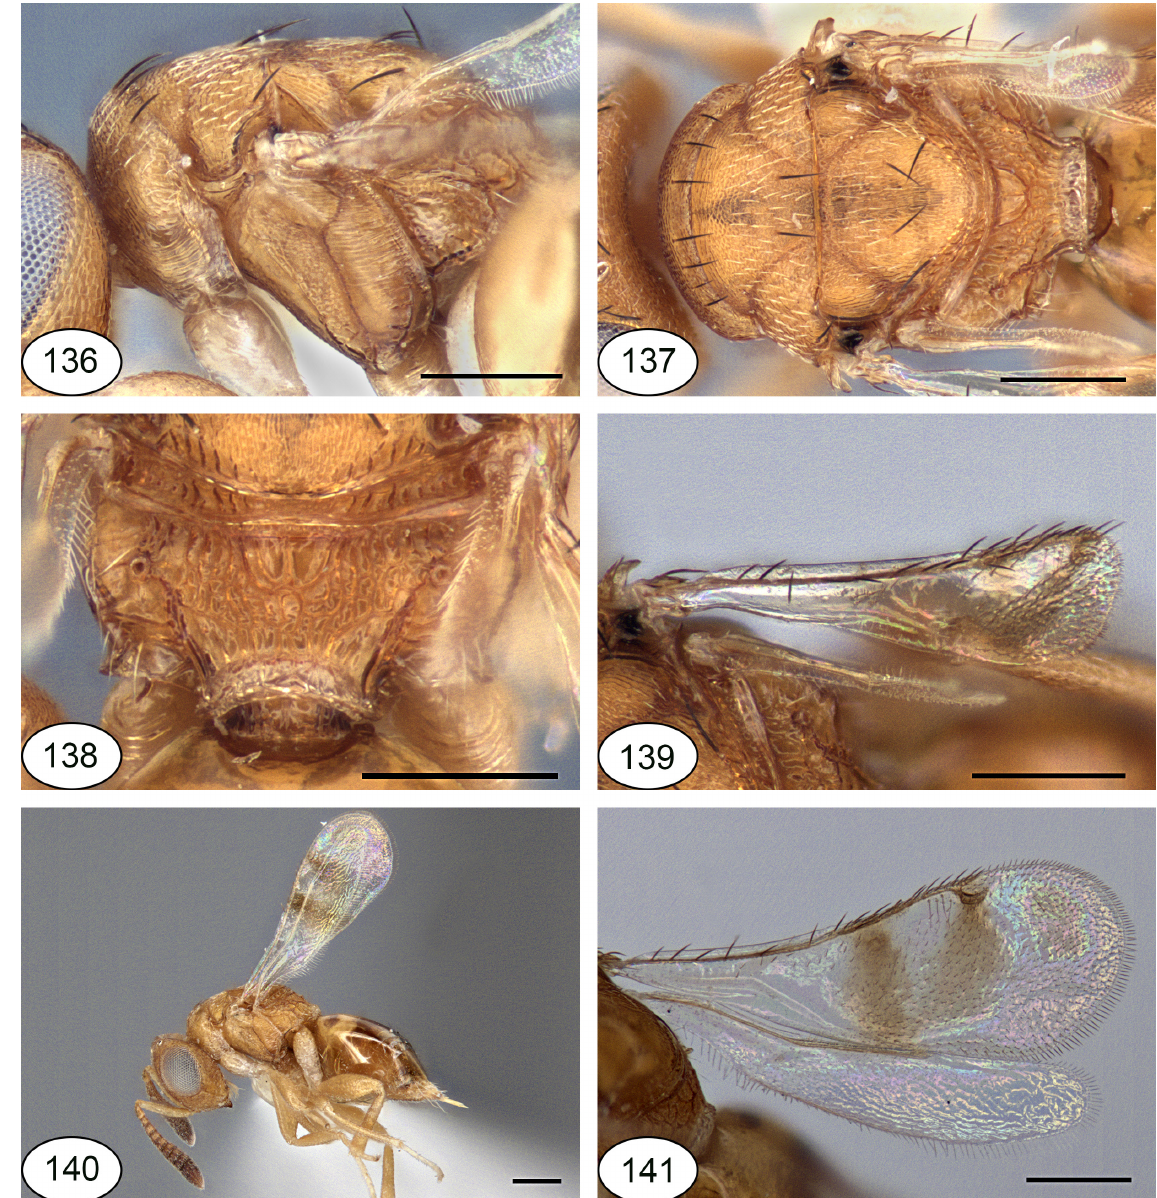
Figs 136–141. Netomocera nearctica Yoshimoto, 1977. 136 . ♀, Missouri (USA), mesosoma, lateral view. 137 . ♀, Missouri (USA), mesosoma, dorsal view. 138 . ♀, Missouri (USA), propodeum, dorsal view. 139 . ♀, Missouri (USA), fore and hind wings. 140 . ♀, California (USA), habitus, lateral view. 141 . ♀, California (USA), fore and hind wings. Scale bars: 0.2